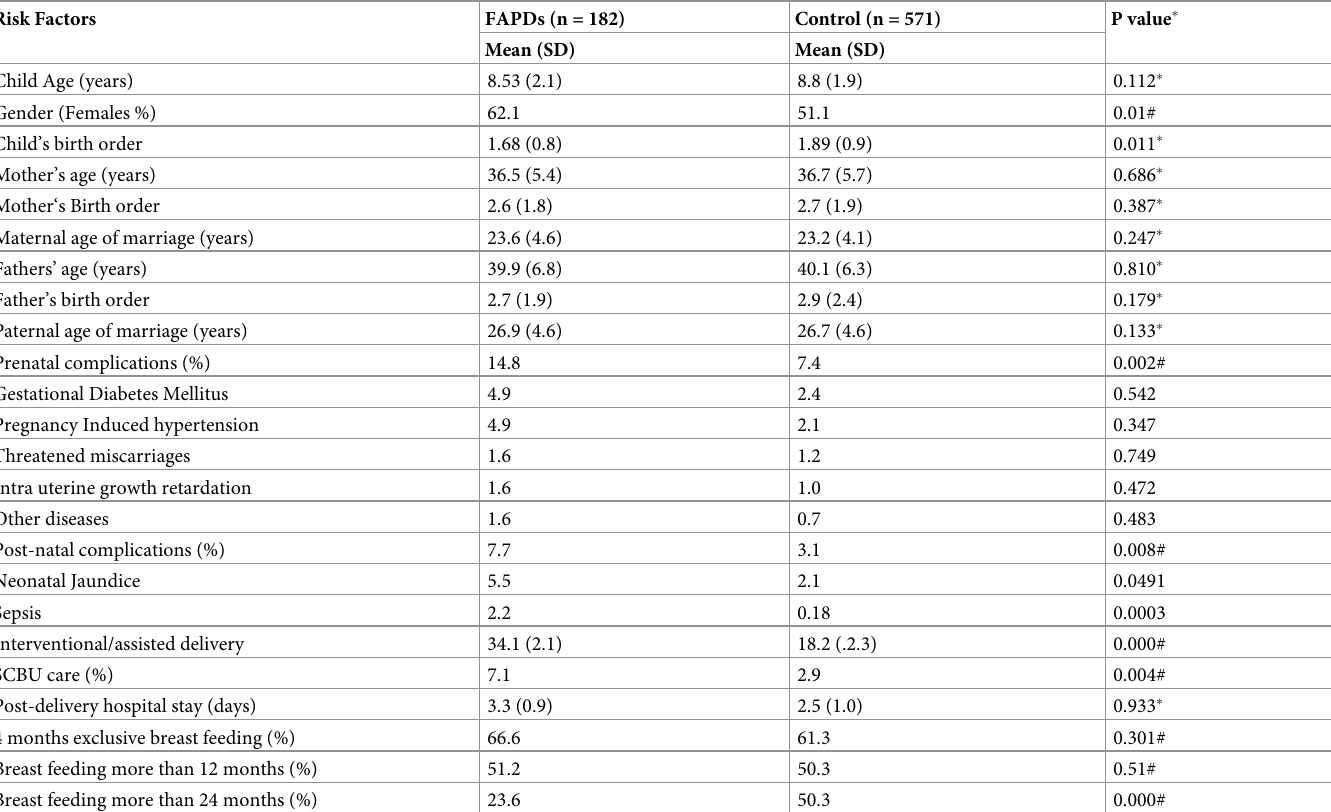
Table 1. Comparison of ELE between FAPDs and healthy